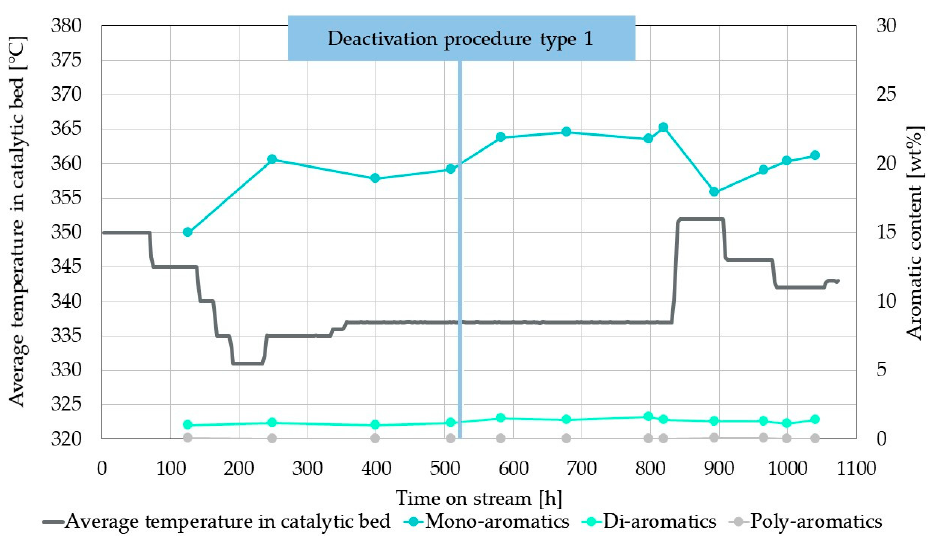
Figure 5. Influence of reaction temperature on the amount of aromatic compounds during the first test.